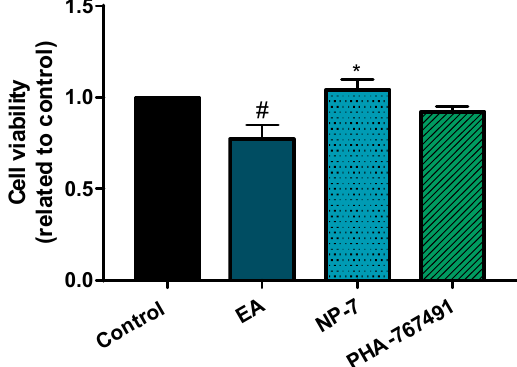
Figure 6. EA (ethacrynic acid)-induced neurodegeneration model. Cell viability after treatment with NP-7 or PHA at 0.5 µ M for 2 h and subsequently with EA (40 µ M) was measured by the 3-(4,5-dimethylthiazol-2-yl)-2,5-diphenyl tetrazolium bromide (MTT) test. Data represent the mean ± SEM. (* p < 0.05, significantly different from SH-SY5Y EA-treated cells, # p < 0.05 significantly different from control).